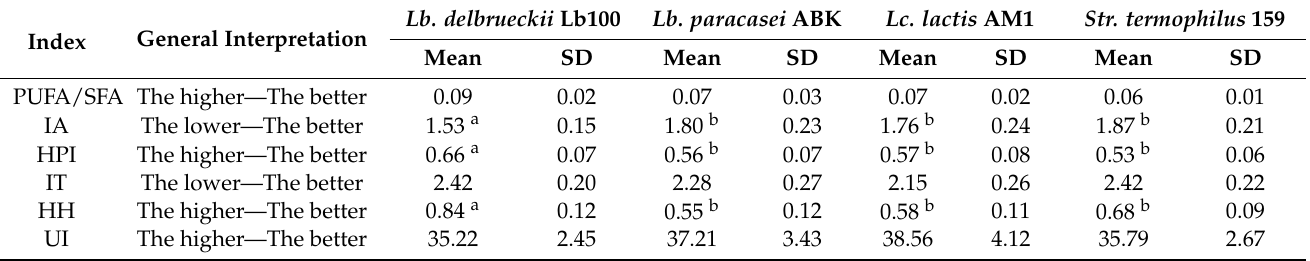
Table 3. Fatty acid (FA) related nutritional indices of the milk fermented by the chosen strains of lactic acid